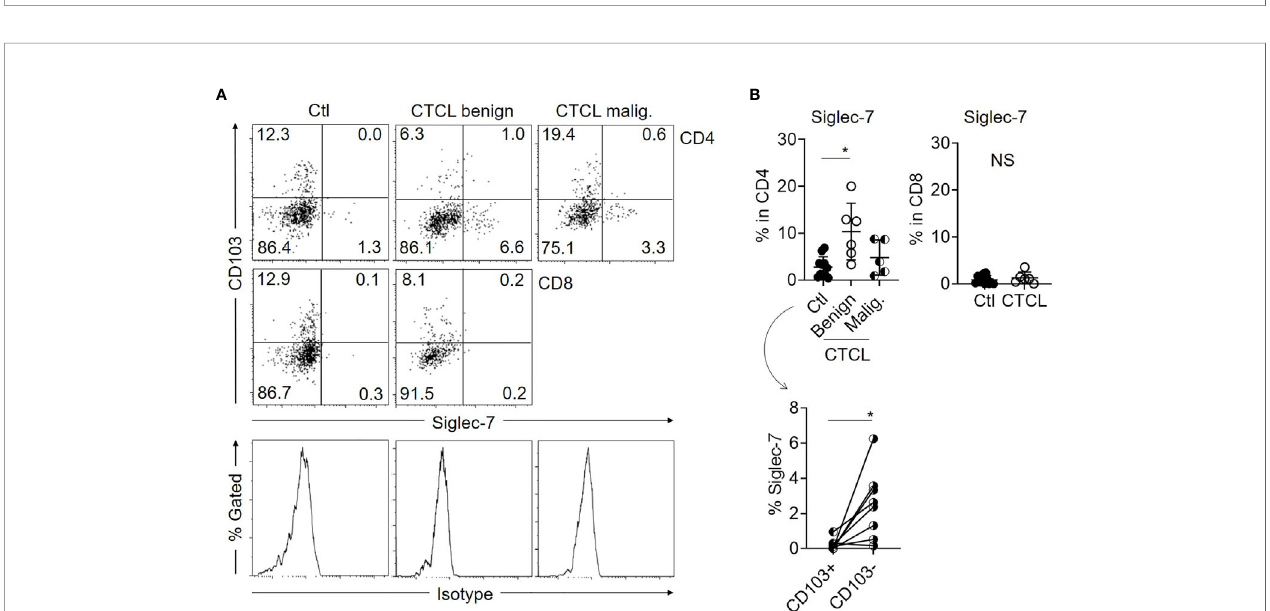
FIGURE 3 | Expression of siglec-7 is augmented in benign CD103 - CD4 T cells of CTCL lesions. (A) Representative dot plots showing the expression of CD103 and siglec-7 in Ctl T cells, benign and malignant T cells from CTCL lesions. Histograms indicate the isotype controls. (B) Top: Graphs of the accumulated data showing the ratio of siglec-7-expressing cells in CD4 (left) and CD8 (right) fractions of Ctl, CTCL benign fraction, and malignant fraction. N = 11 in Ctl, n = 6 in CTCL benign, n = 5 in CTCL malig. Bottom: The ratio of siglec-7 + cells in CD103 + CD4 and CD103 - CD4 fractions of Ctl skin specimens. N = 8. * p < 0.05. NS, not signi fi